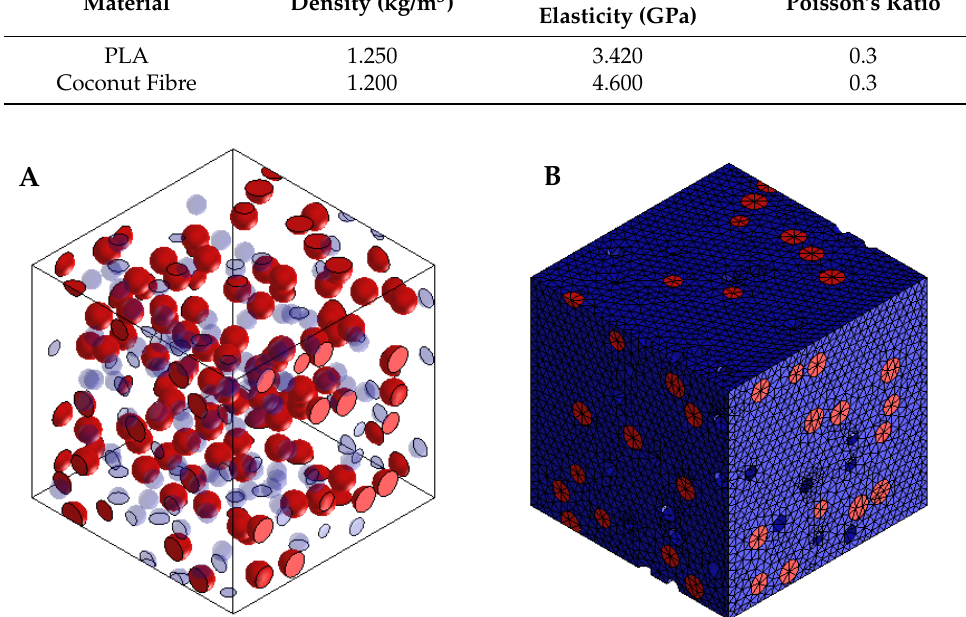
Figure 1. ( A ) Assembly and ( B ) mesh of model of PLA-coconut fibre reinforced composite. Table 2. Material properties of PLA and coconut fibre used for RVE analysis.